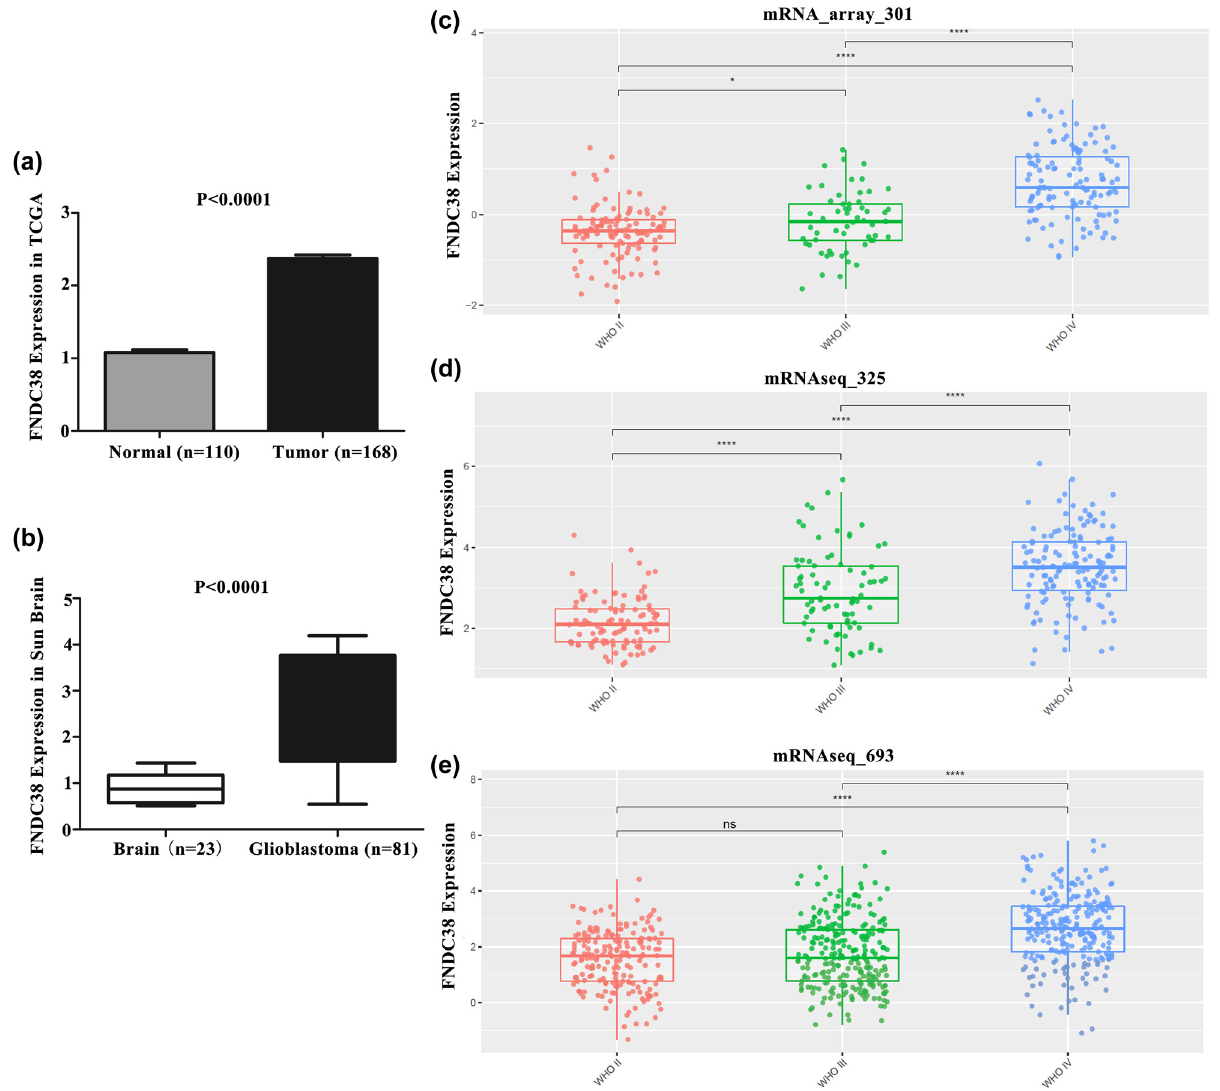
Figure 4: FNDC3B was highly expressed in glioblastoma. The di ff erential expressions of FNDC3B in glioblastoma patients and healthy control were analyzed based on the ( a ) TCGA, ( b ) Oncomine Sun Brain, ( c ) CGGA mRNA_array_301 database, ( d ) CGGA mRNAseq_325 database and ( e ) CGGA mRNAseq_693